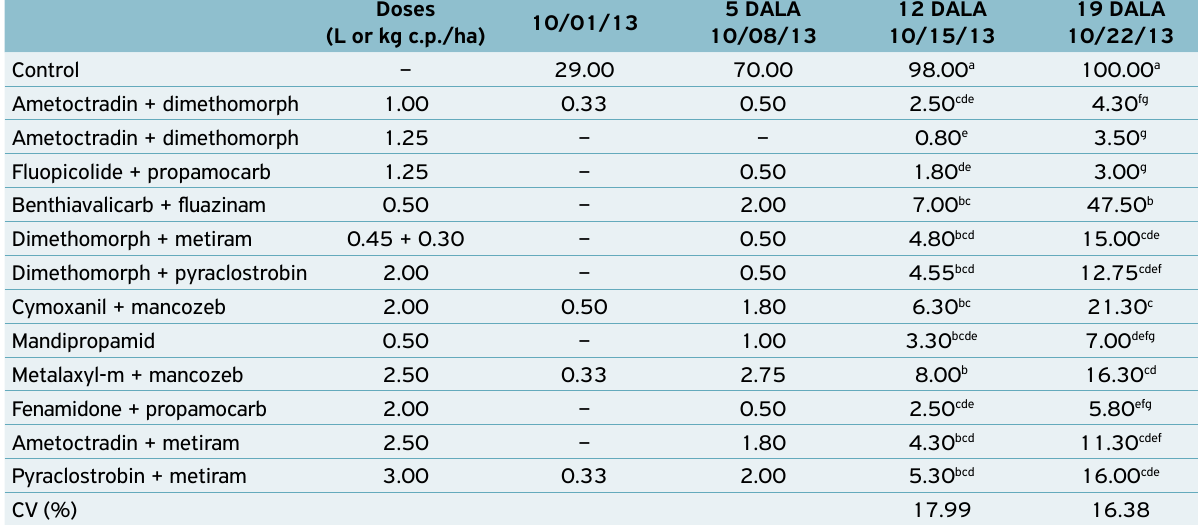
Table 1. Severity of late blight in potato plants, Ágata cultivar, treated with fungicides at 5, 12, and 19 days after the last application. Pilar do Sul, São Paulo, 2013.